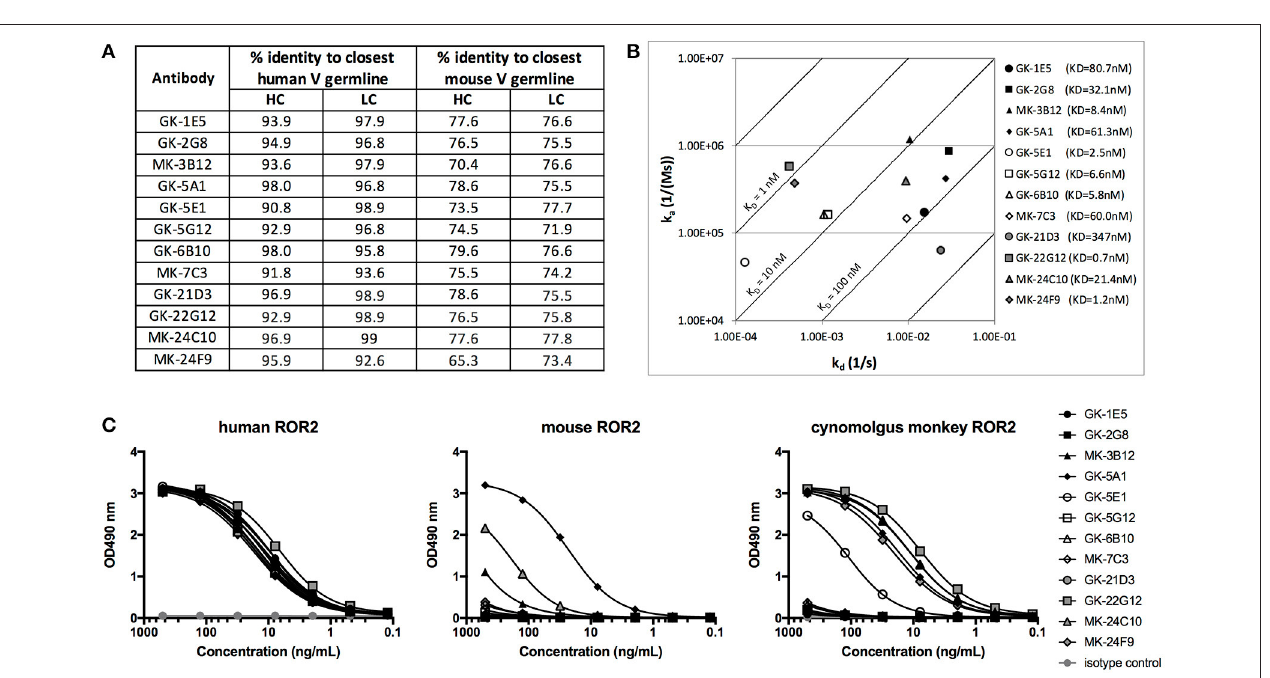
FIGURE 6 | Characterization of novel hROR2-specific antibodies. (A) Identity to the closest human and mouse germline V gene sequence for heavy (HC) and light chain (LC) as a measure of “humanness” was evaluated in silico using IgBLAST. (B) Isoaffinity plot showing association (k a ) and dissociation constants (k d ) as determined by surface plasmon resonance (SPR) using clonal supernatants. Diagonal lines represent equal affinities. (C) Purified antibodies were assessed for binding to soluble human, cynomolgus monkey and mouse ROR2-ECD-Twin-Strep by